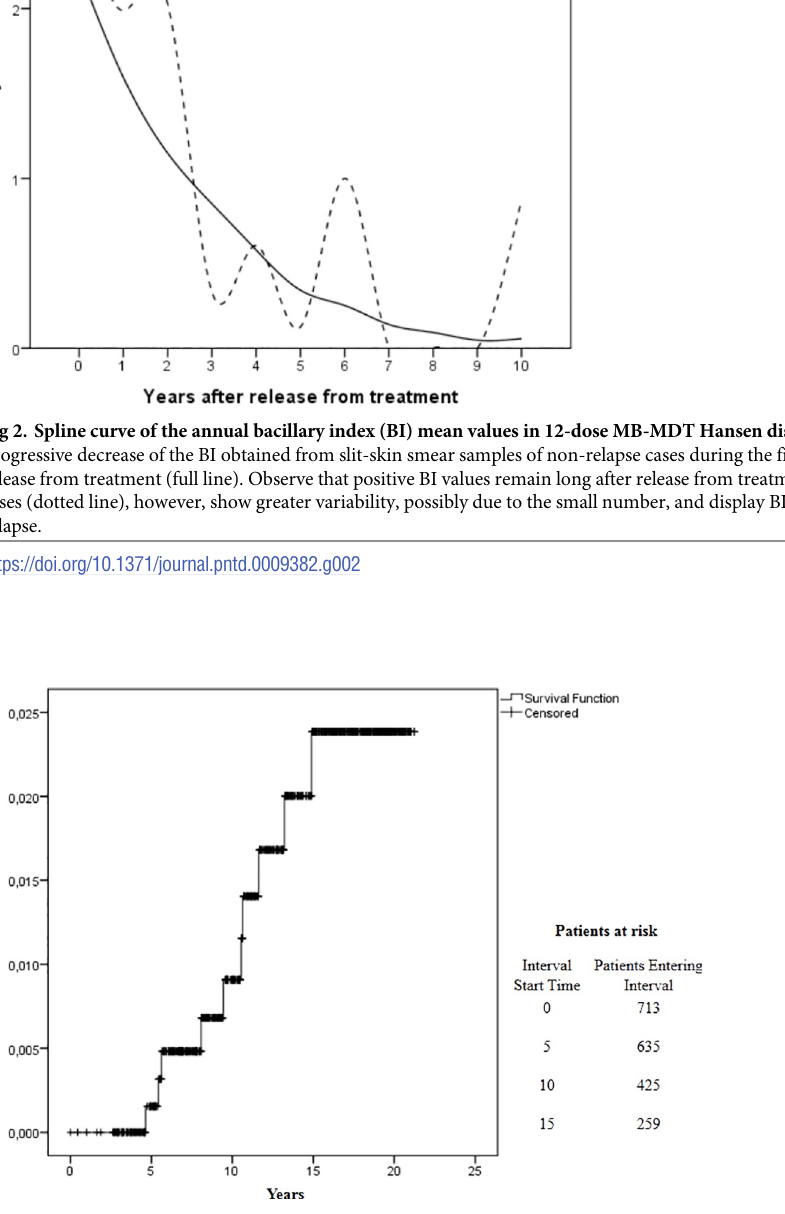
Fig 3. Kaplan-Meier Cumulative Risk of relapse in 713 patients treated with 12-dose MB-MDT. The survival curve shows the proportion of people affected by Hansen disease without relapse according to the period of follow-up. Y-axis of the curve is the cumulative probability of relapse. The X-axis represents the survival duration. The length of the horizontal lines is the interval terminated by the occurrence of relapse events and the heights between horizontal lines illustrate the change in the cumulative